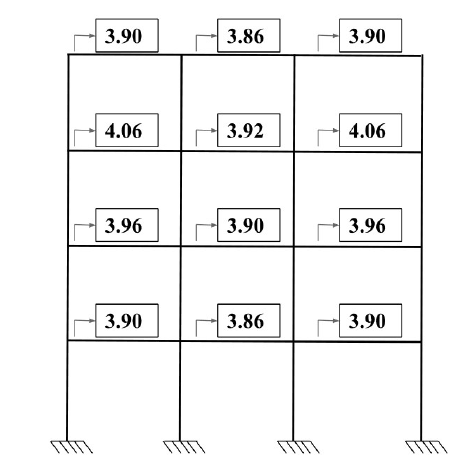
for the beam elements. 𝛽𝛽 𝑀𝑀𝑀𝑀